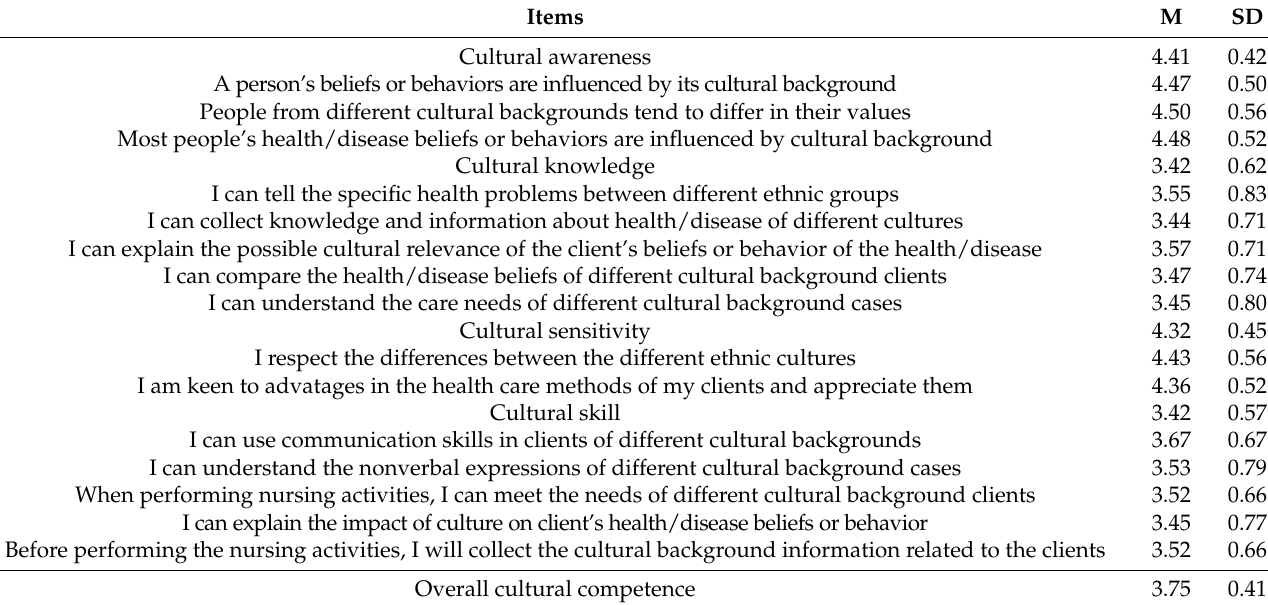
Table 2. The distribution of cultural competence among